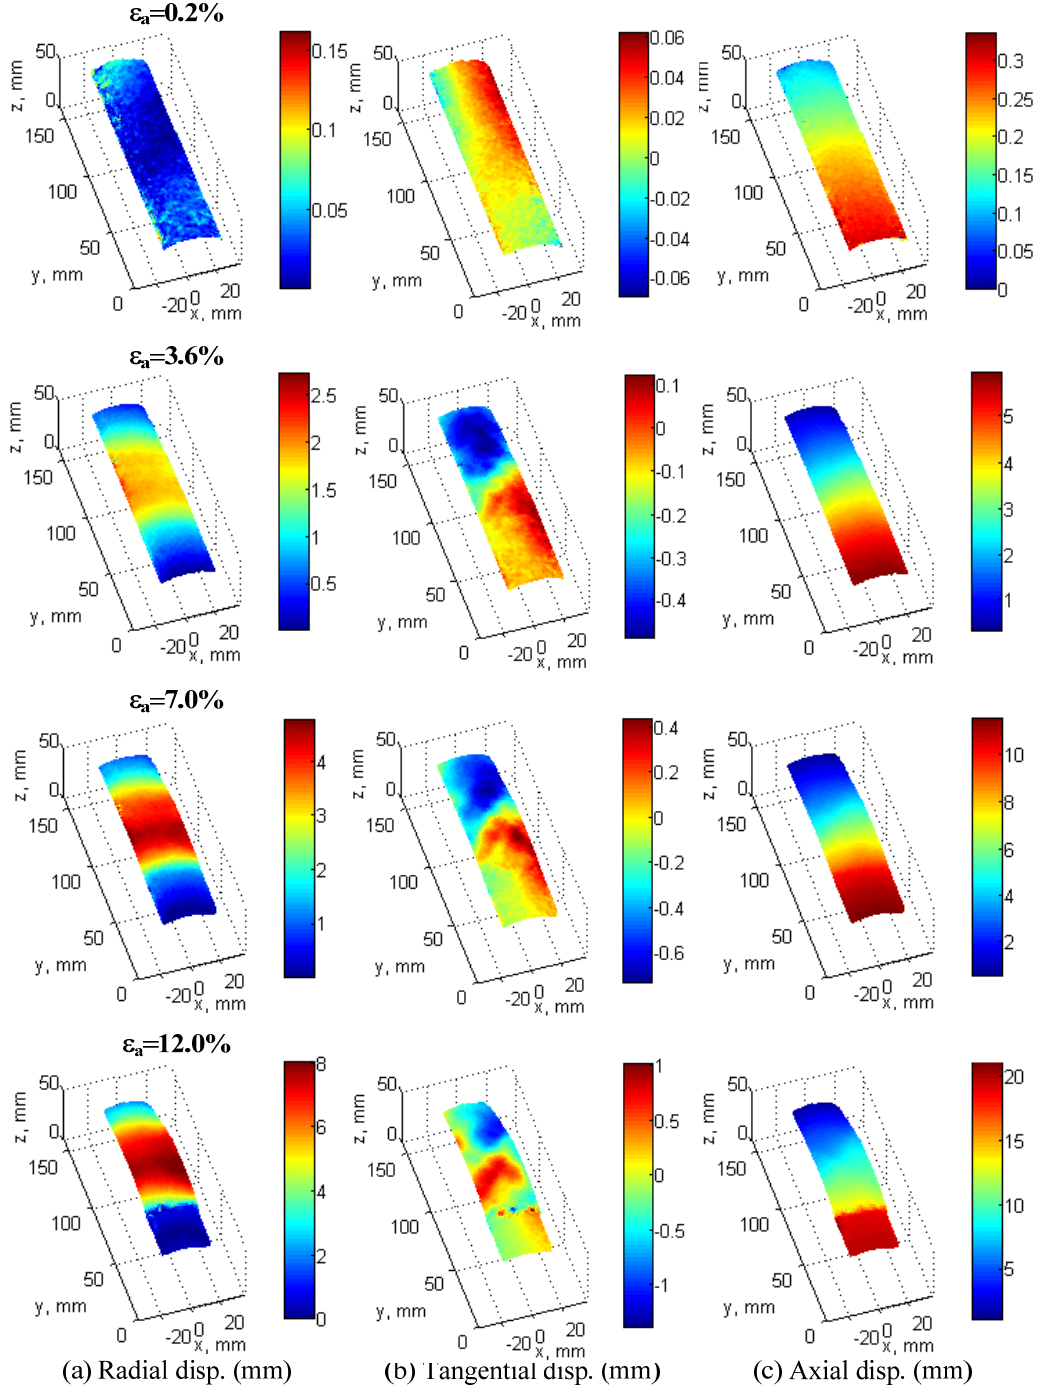
Figure 17. Cumulative displacement fields of test 120904c using cylindrical coordinates at 0.2%, 3.6%, 7%, and 12% of axial strain: radial displacement field ( a ), tangential displacement field ( b ), and axial displacement field ( c ).